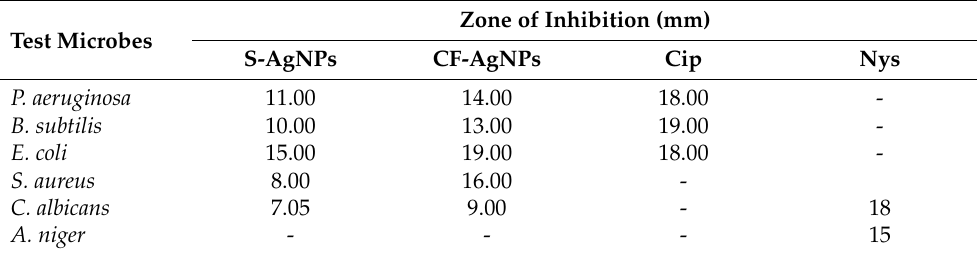
Table 1. Antimicrobial activity of AgNPs produced by Streptomyces sp. ASM23 cell supernatant (CS-AgNPs) and cell filtrate